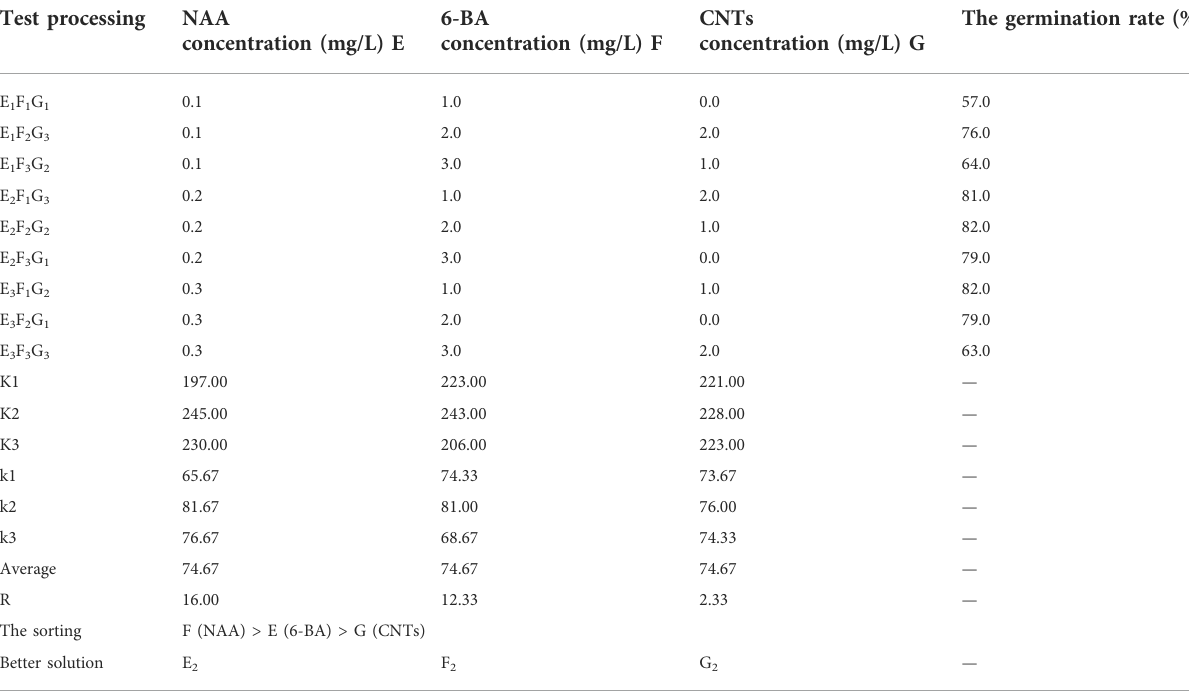
TABLE 2 Statistical results of orthogonal experimental design for germination rate of calla lily. Test processing